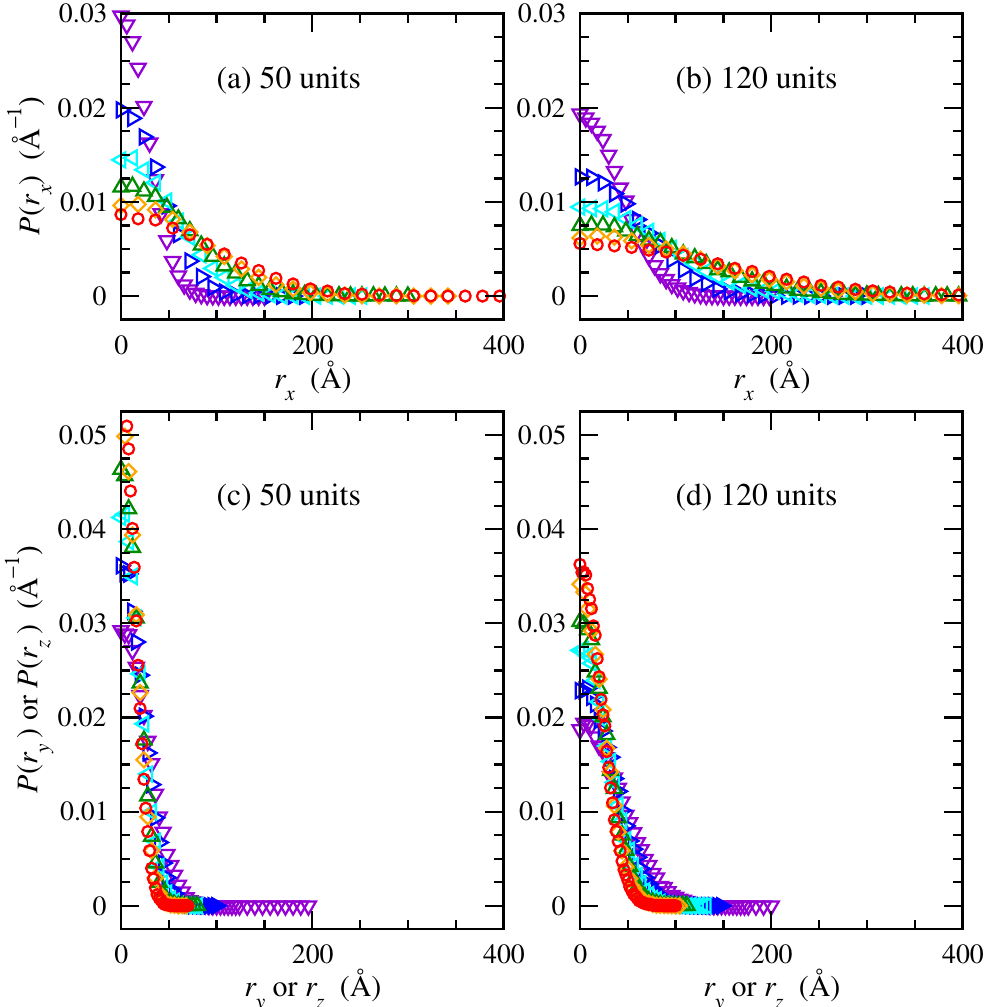
Figure 3. Probability density distributions of end-to-end vectors in the ( a , b ) x and ( c , d ) y and z directions for trans-1,4-polybutadiene RIS chains of ( a , c ) 50, and ( b , d ) 120 repeat units at 343 K. Deformation ratios ( λ ): 1 ( (cid:79) violet); 1.5 ( (cid:46) blue); 2 ( (cid:47) cyan); 2.5 ( (cid:77) green); 3 ( (cid:5) orange); 3.5 ( ◦